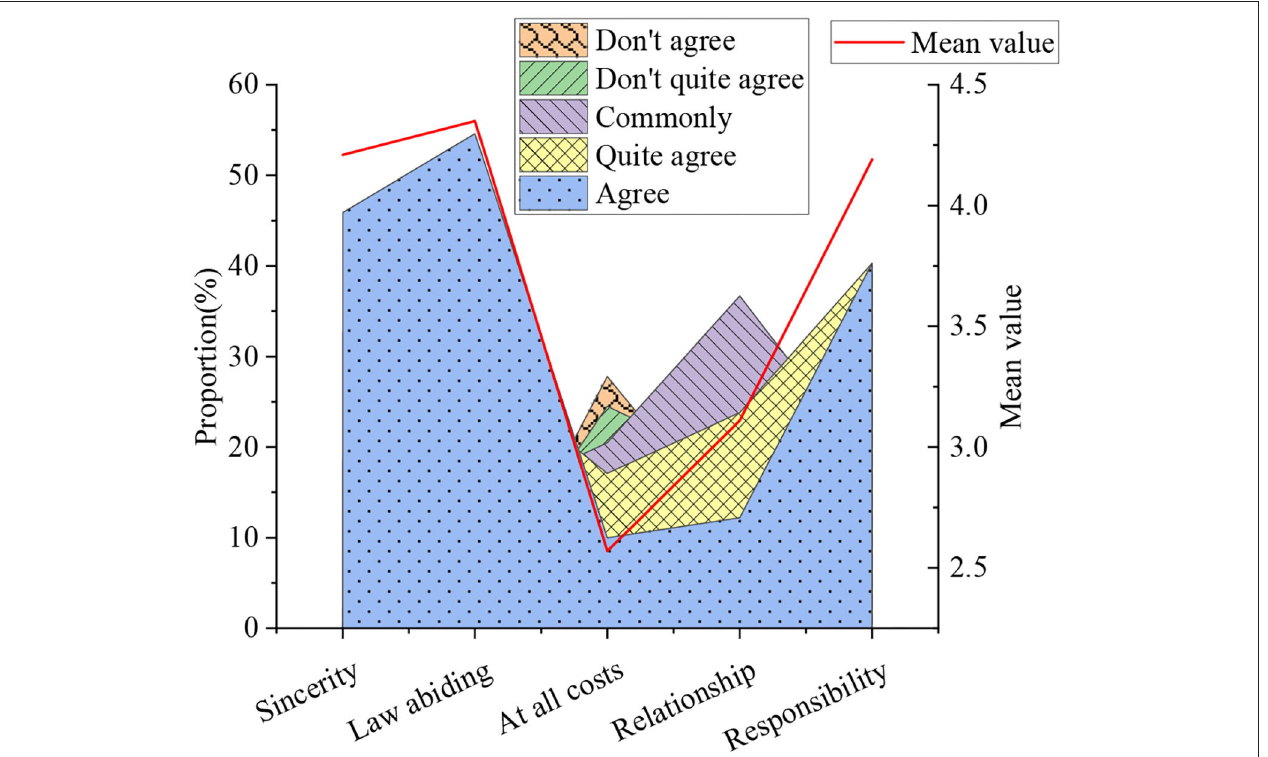
FIGURE 12 | The basic situation of entrepreneurship